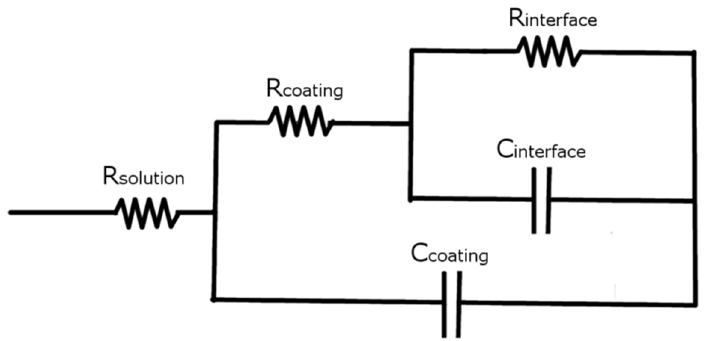
Figure 9. The equivalent circuit used to model the impedance data of a permeable coating.